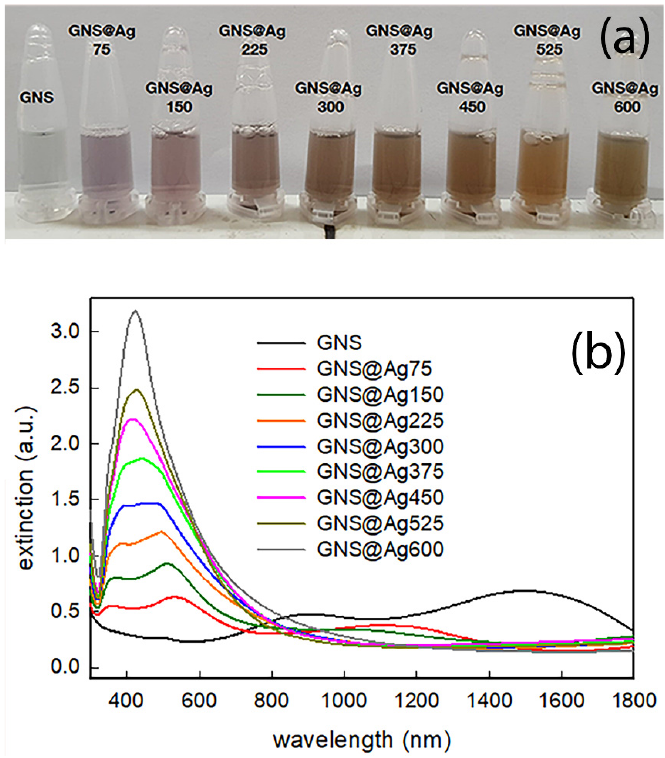
Figure 1. ( a ) photograph of colloidal suspensions (after dilution 1:3 with bidistilled water) of GNS (first vial) and GNS@Ag obtained with increasing silver/ascorbic acid addition; ( b ) UV–vis–NIR spectra of all the investigated samples.